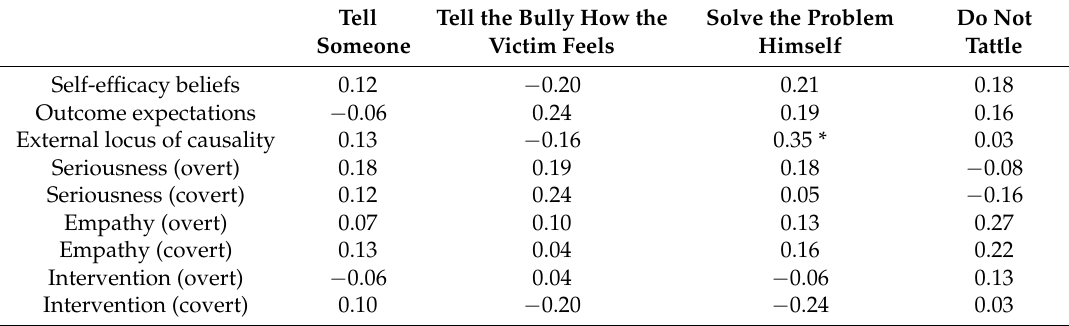
Table 4. Correlations among variables in Greek PST (N = 84).